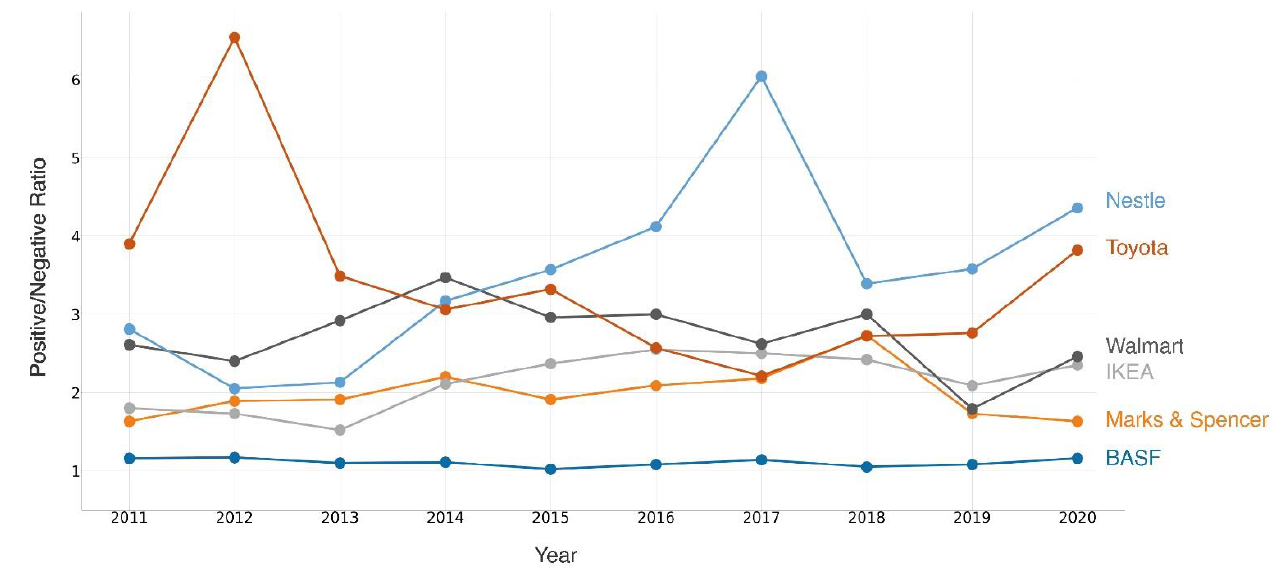
Figure 7. Rates of positive/negative comments.